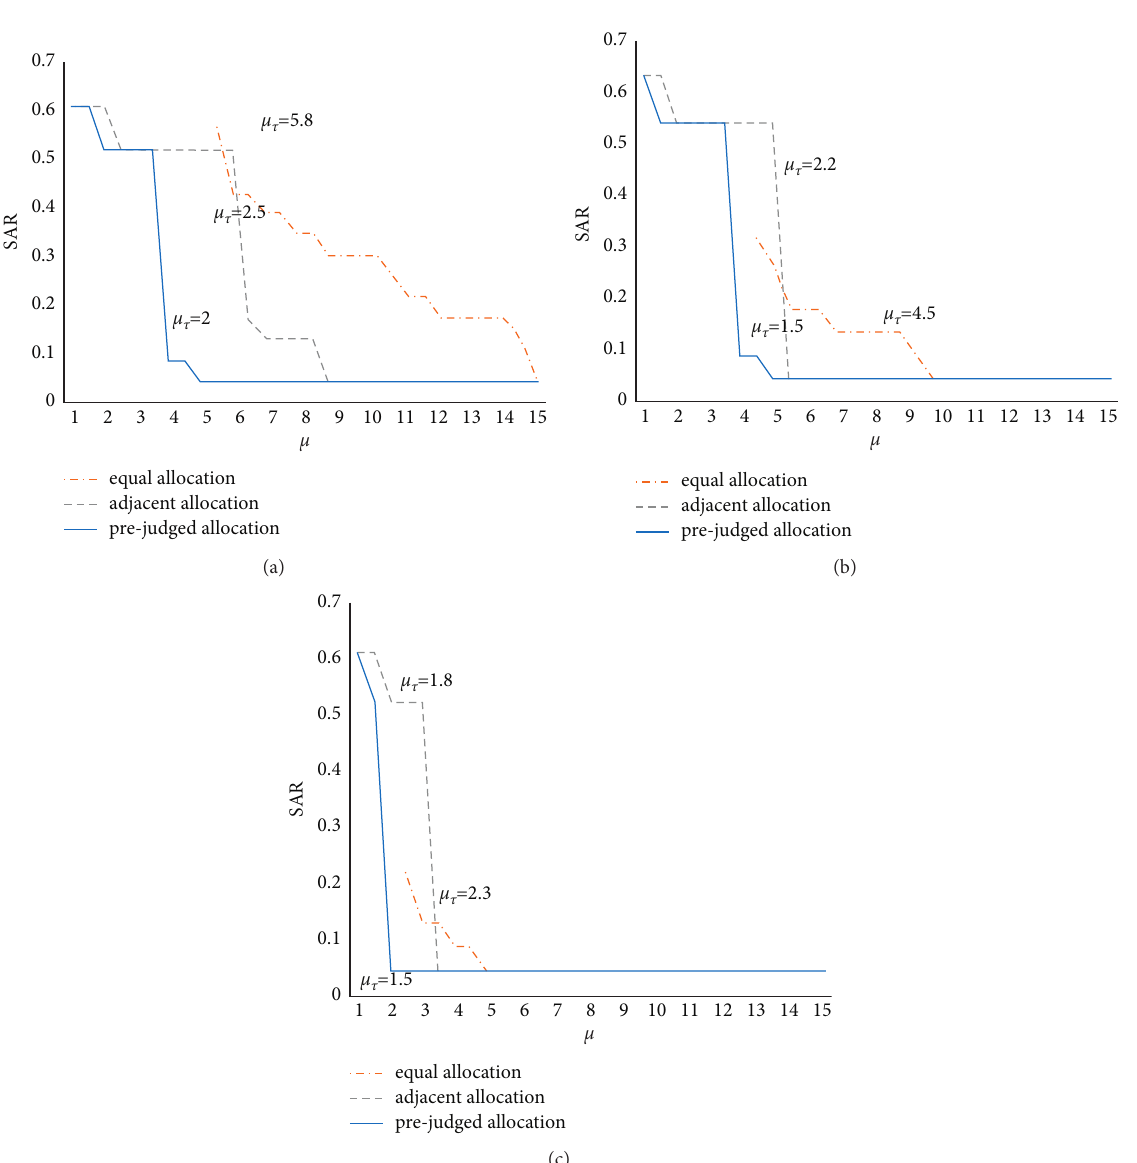
Figure 8: SAR value under different allocation strategies. (a) θ � 0.6, (b) θ � 0.7, (c) θ �